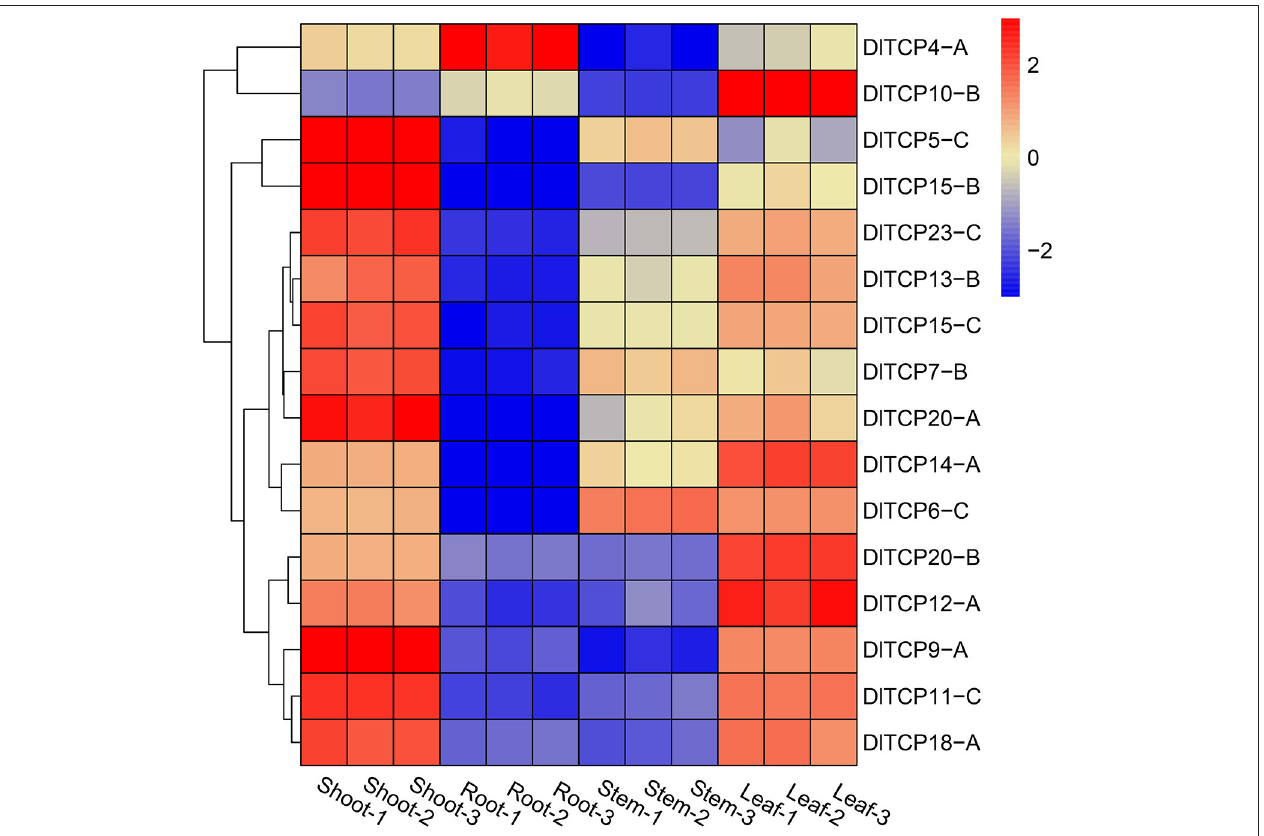
FIGURE 6 | Tissue expression pattern of TCP genes in Ma bamboo. The expression levels of putative TCP members in bamboo shoots, roots, stems, and leaves were normalized and visualized by R (4.0.2). Red and blue represent high and low expression levels, respectively. 1, 2, and 3 represent three biological replicates,